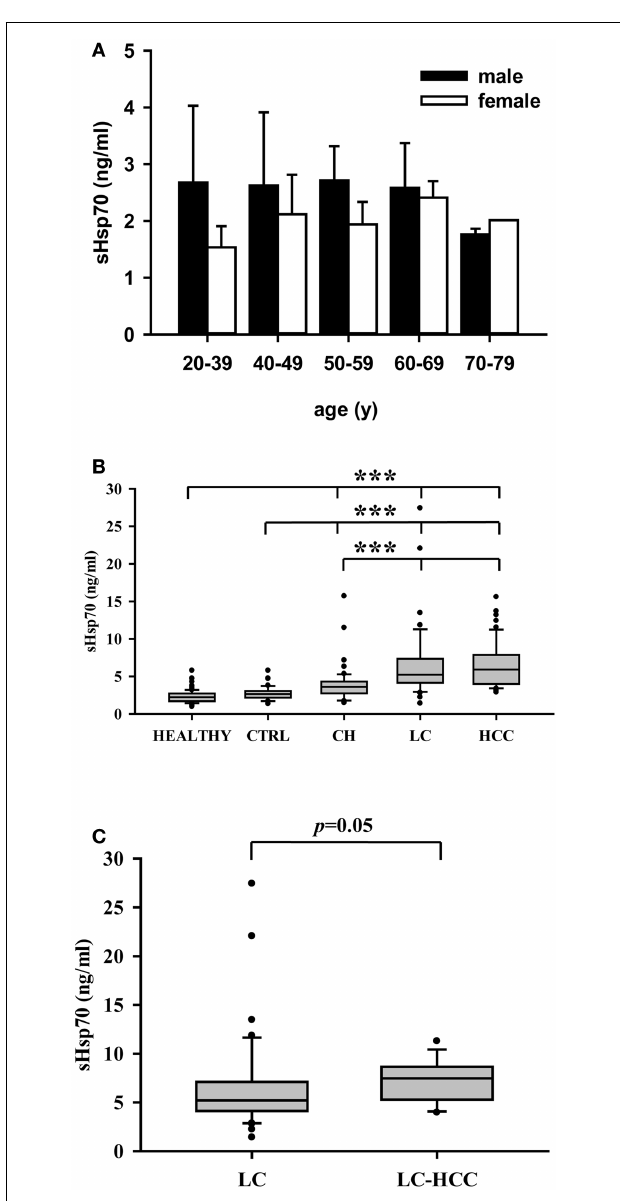
FIGURE 3 | (A) HSP70 protein levels in the serum of male ( n = 54) and female ( n = 32) healthy human volunteers at different ages ( n = 86).The HSP70 serum levels did neither differ significantly in male and female healthy human individuals nor in different age groups ranging from 20–39, 40–49, 50–59, 60–69, to 70–79. (B) HSP70 protein levels in healthy human volunteers (HEALTHY, n = 86), healthy controls without liver diseases (CTRL, n = 40), patients with chronic hepatitis (CH, n = 50), liver cirrhosis (LC, n = 46), and hepatocellular carcinomas (HCC, n = 47). Serum HSP70 levels did not differ significantly between healthy human volunteers and controls without liver diseases, but both groups differed significantly to patients with CH, LC, and HCC. (C) HSP70 protein levels in the serum of patients with liver cirrhosis (LC, n = 46) and of HCC patients with an underlying LC (LC–HCC, n = 13). Serum HSP70 levels were higher ( p = 0.05) in patients with HCC and an underlying LC compared to patients with LC only. Serum HSP70 levels were determined by sandwich ELISA. Values were determined at least three times in duplicates. Median values are shown as box plots. Significance was calculated by using the Mann–Whitney- U -test (*** p <